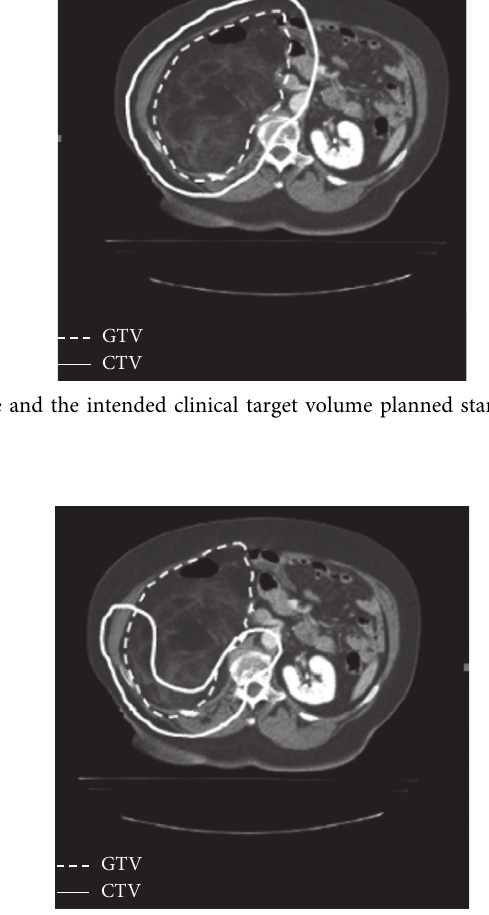
Figure 2: Gross tumor volume and intended clinical target volume planned according to our Table 1: Patient characteristics.